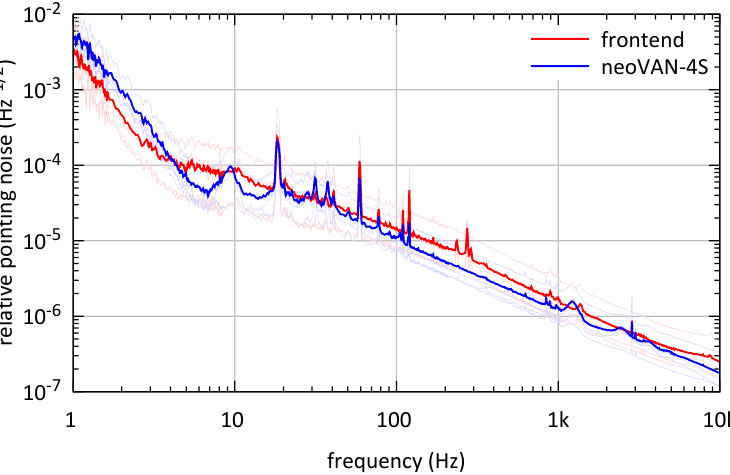
Figure 4. Relative pointing measurements of the front-end laser beam and the laser beam amplified by the neoVAN-4S amplifier. The two curves are each representing the mean values of the four lighter curves in the same color that show the measurements of the four alignment degrees of freedom for each laser. The relative pointing noise is not increased by the neoVAN-4S